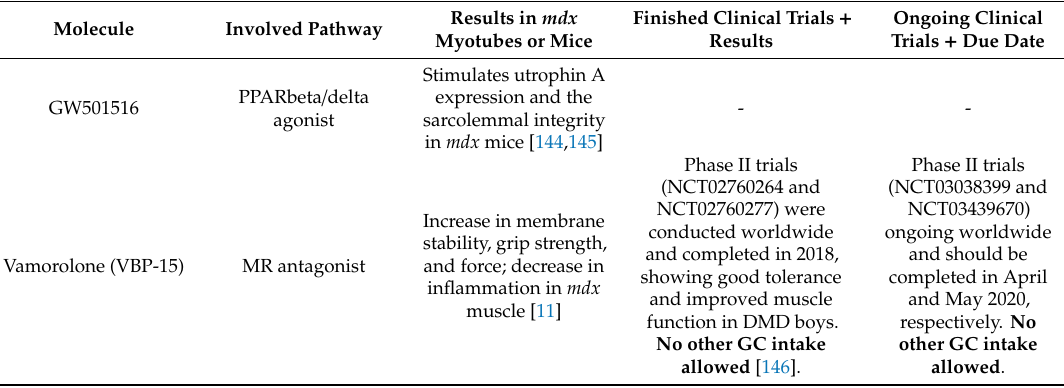
Table 8. Overview of nuclear receptor stabilizing molecules: results in mdx myotubes (in vitro) or mice (in vivo), finished clinical trials and results, ongoing clinical trials and due dates, and putative molecules. Results in mdx Finished Clinical Trials + Ongoing Clinical Molecule Involved Pathway Myotubes or Mice Results Trials + Due Date Stimulates utrophin A PPARbeta / delta expression and the GW501516 - - agonist sarcolemmal integrity in mdx mice [144,145] Phase II trials (NCT02760264 and NCT02760277) were Increase in membrane conducted worldwide stability, grip strength, and completed in 2018, Vamorolone (VBP-15) MR antagonist and force; decrease in showing good tolerance inflammation in mdx and improved muscle muscle [11] function in DMD boys. No other GC intake allowed